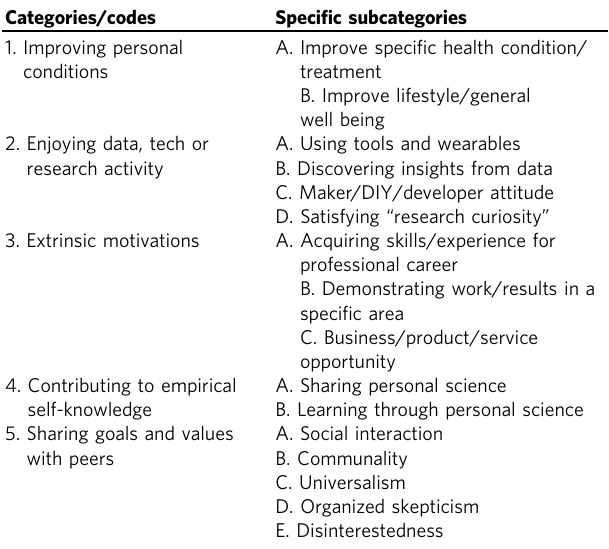
Table 1 Codebook with categories and subcategories for the interpretation of